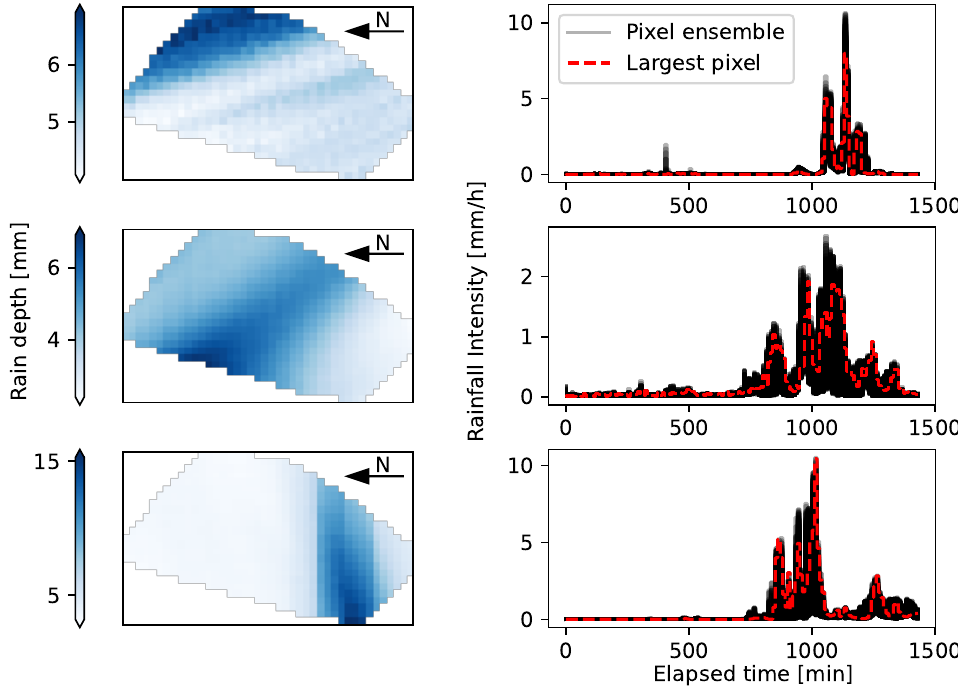
Figure 9. Generated 5-year storms for a duration 1440 min, shown on the left. The storms was arbitrarily selected. On the right, time series for each individual pixel is shown (black) and the largest pxiel based on accumulated rain depth (dashed red